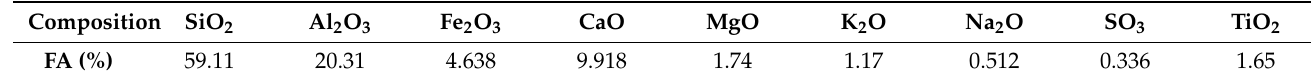
Table 1. XRF analysis of the fly ash.